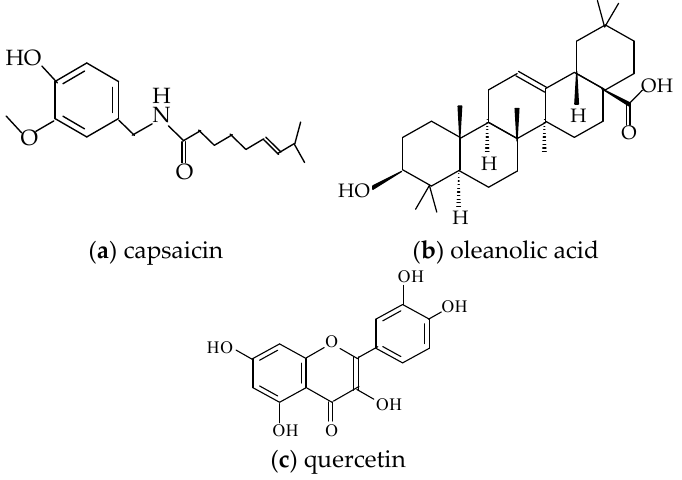
Figure 9. Molecular structures of ( a ) capsaicin, ( b ) oleanolic acid and ( c ) quercetin.